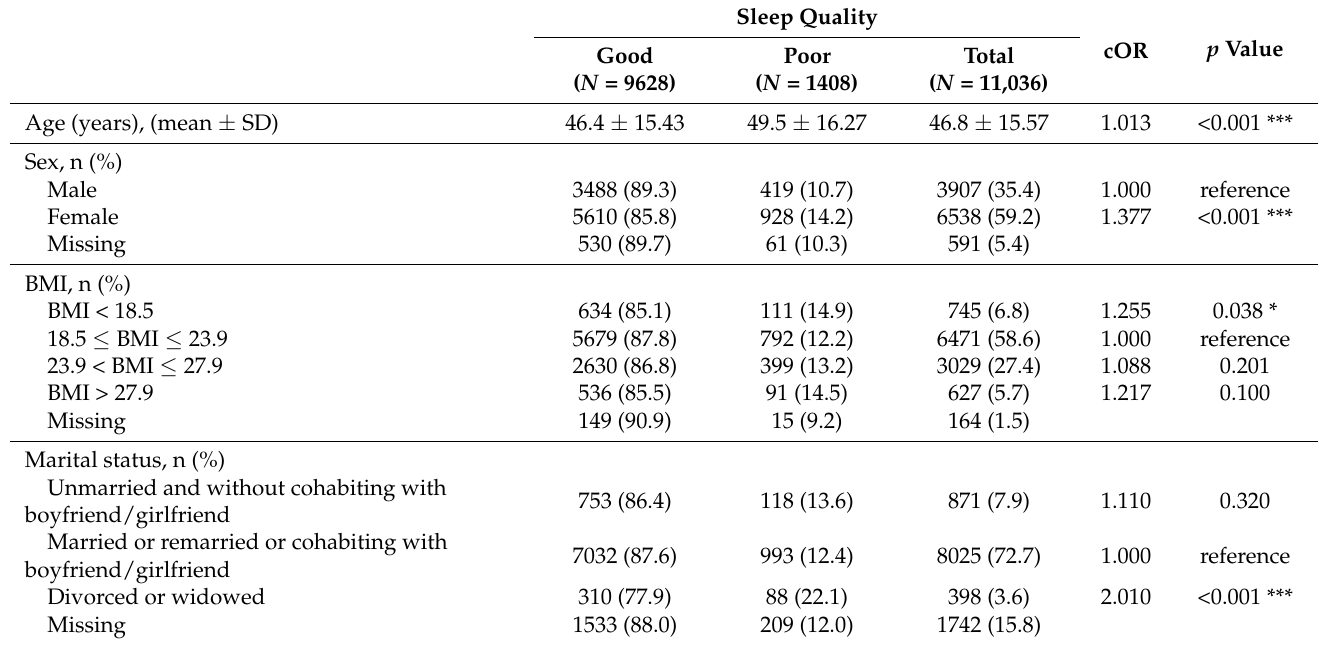
Table 1. Characteristics of Participants and crude odds ratio